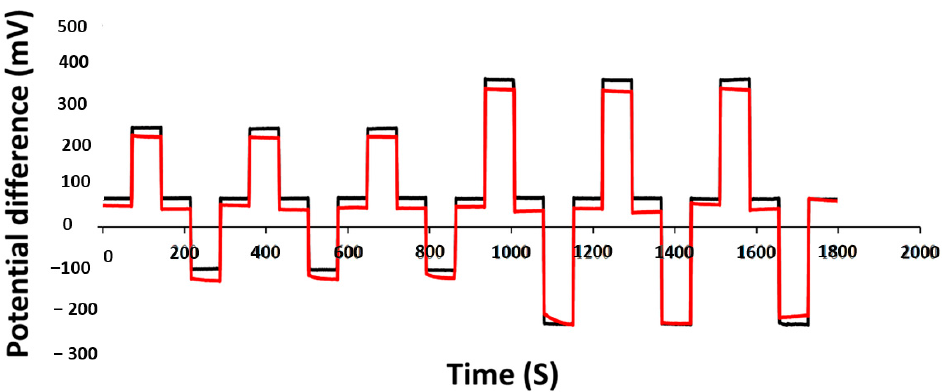
Figure 8. Potential versus time recording for TiN working electrode in pH 7 buffer ( black ), reducing agent ( red ) vs. glass